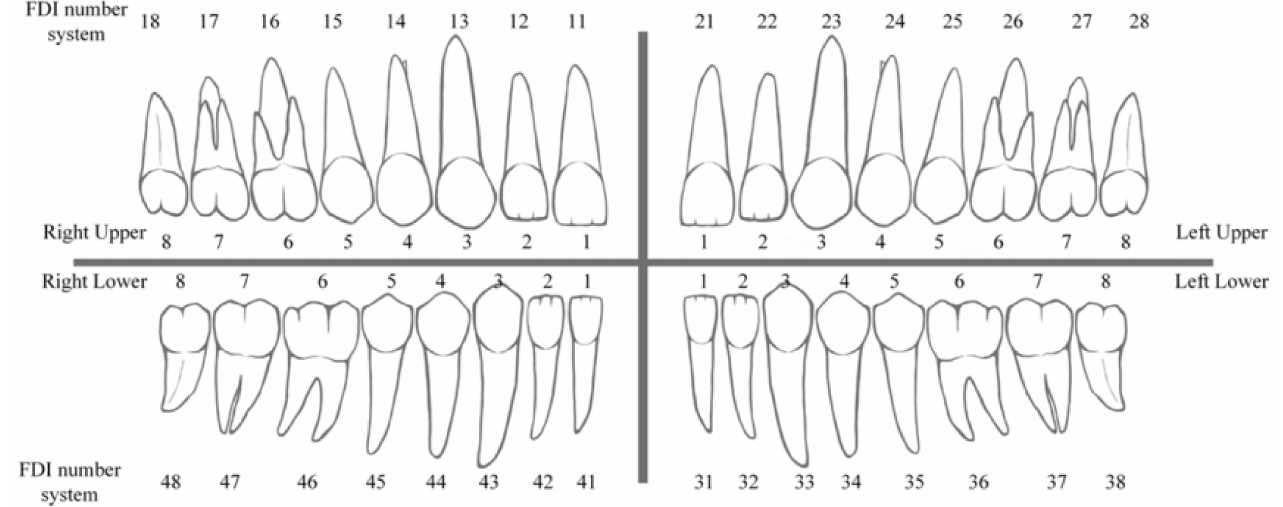
Figure 22. FDI World Dental Federation notation